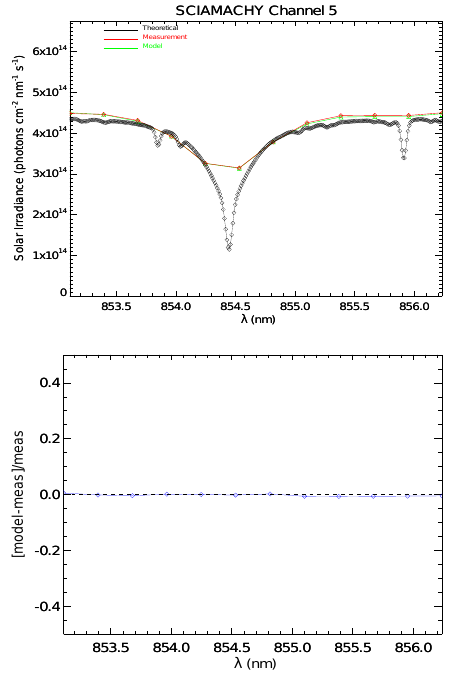
Figure 7. Similar to Figure 3 but for Channel 5 and Line 1. The corresponding retrieved ISRF is a Hyperbolic function with a FWHM (cid:39) 0.57 nm. The residuals ( bottom graph ) rms (cid:39) 0.005.